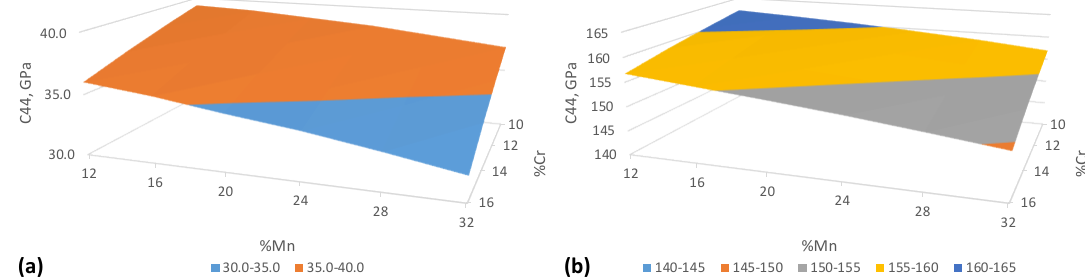
Figure 4. Elastic constants of FeCr 10–16 Mn 12–32 alloys: ( a ) C (cid:48) ; ( b ) C 44 at 300 K in